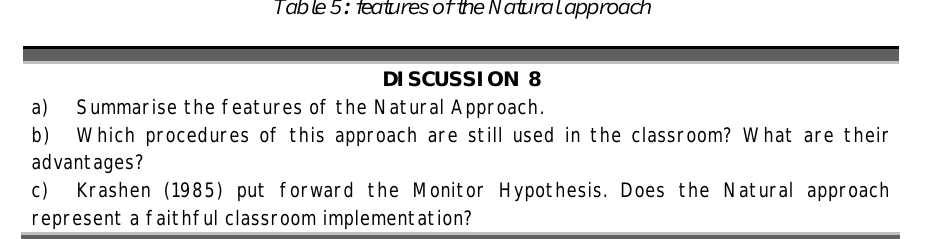
Table 5: features of the Natural